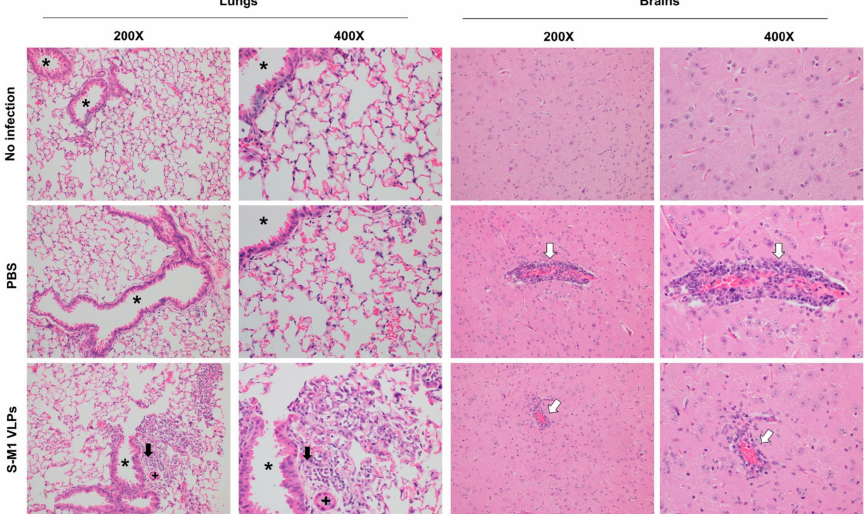
Figure 7. Histopathological analyses of S-M1 VLP vaccinated mice. Tissue samples were collected post mortem and embedded in paraffin. The samples were then sectioned and stained with hematoxylin- eosin. * indicates airway, + indicates blood vessel, black arrows indicate peribronchiolar accumulation of lymphocytes, plasma cells, and histiocytes. White arrows indicate Virchow–Robin spaces expanded by lymphocytes and plasma